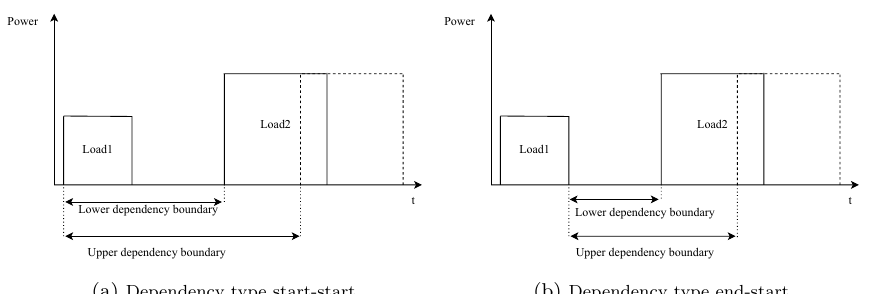
Fig. 2 Dependencies between different